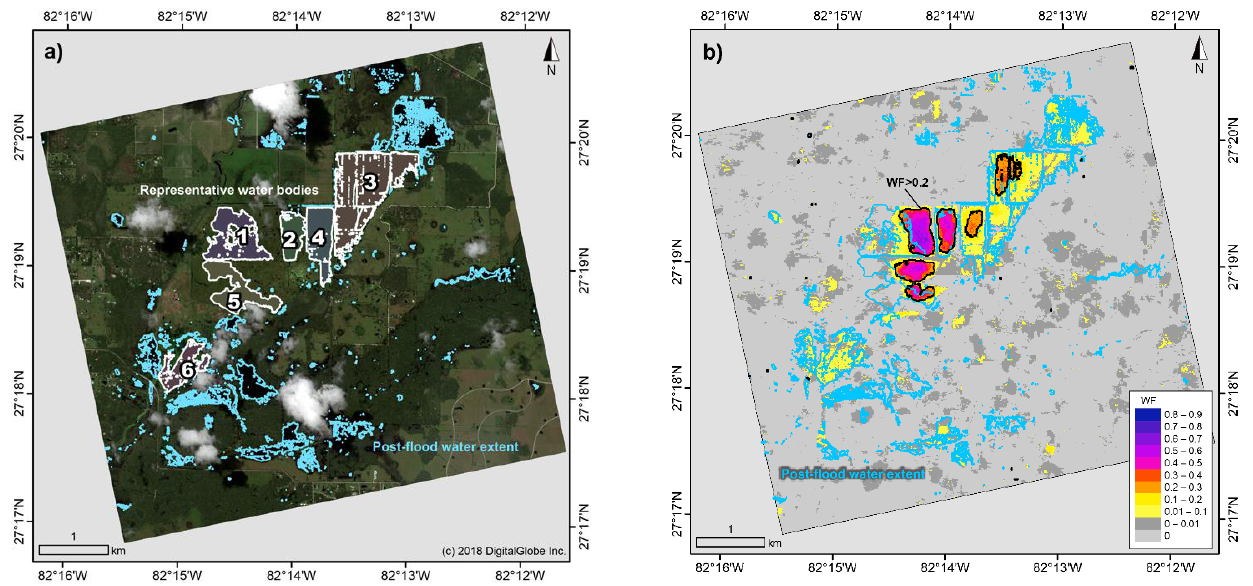
Figure 3. Optically derived water extent ( a ) after flood (12 September 2017) and ( b ) in general status shown in WF. ID numbers are assigned in representative six post-flood water bodies. Contour lines in black denote an example coastline of usual water extent (>0.2).